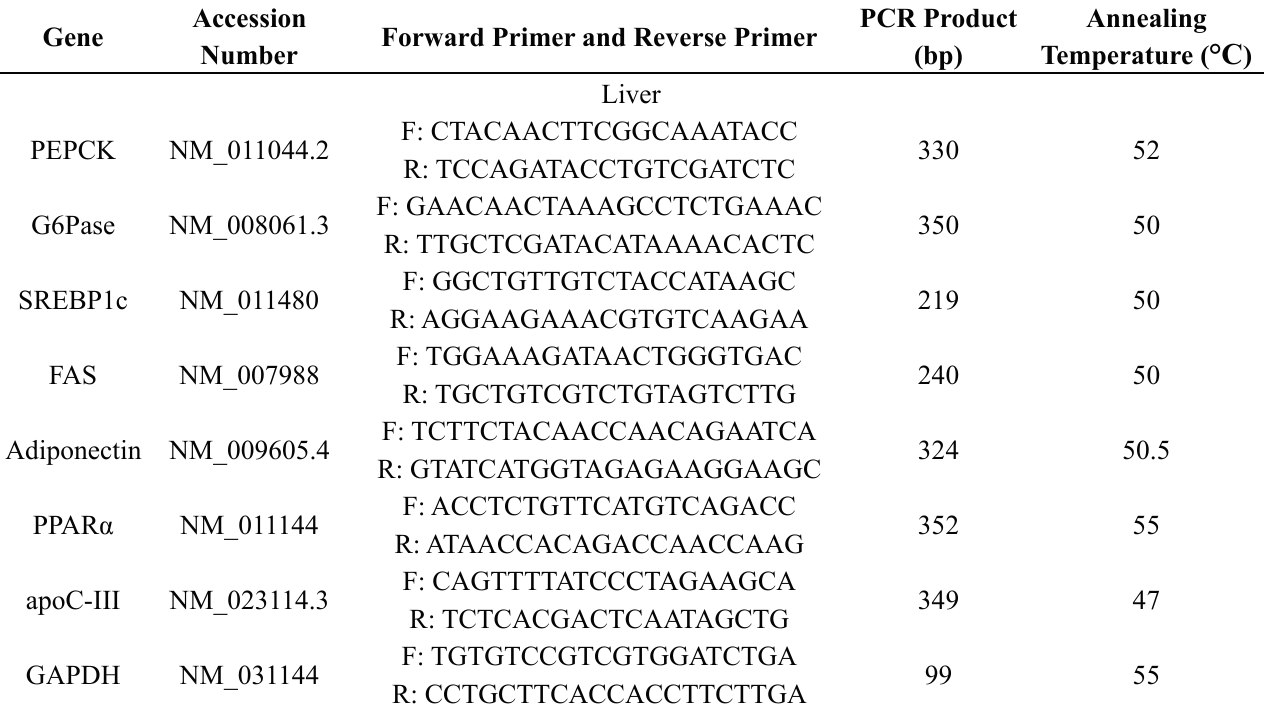
Table 3. Primers used in this